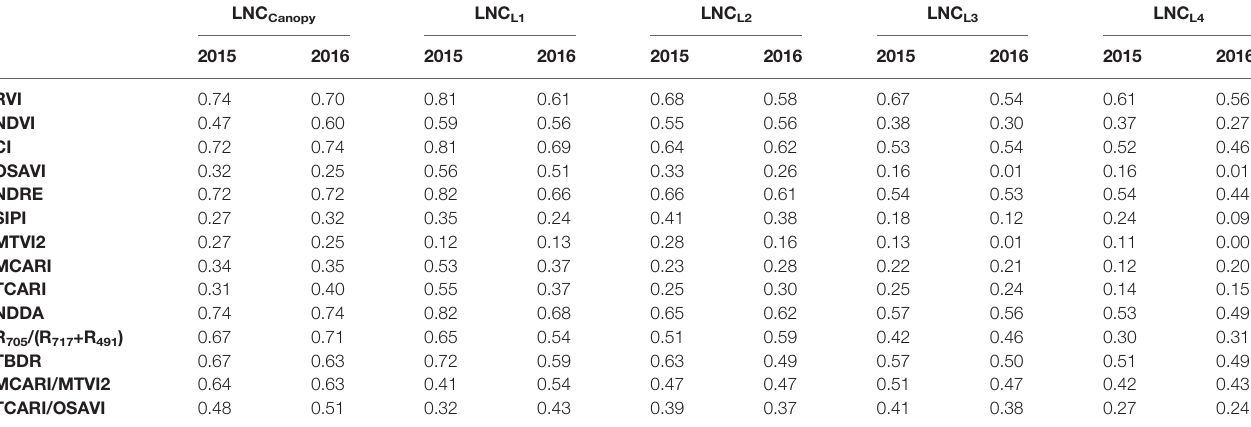
TABLE 3 | Coef fi cients of determination (R 2 ) for the relationship between the vegetation indices and the leaf nitrogen concentration in different